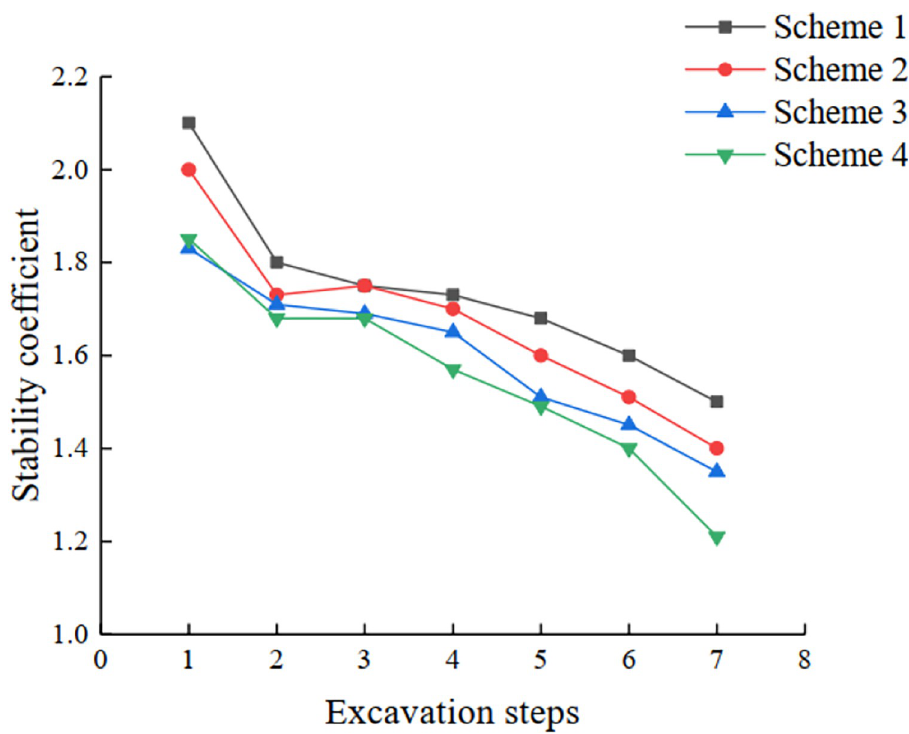
Fig 16. Curves of stability coefficients for schemes 1 to